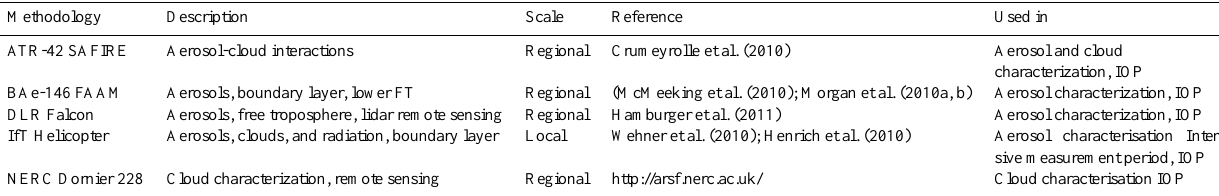
Table A3. Airborne infrastructures used in EUCAARI.